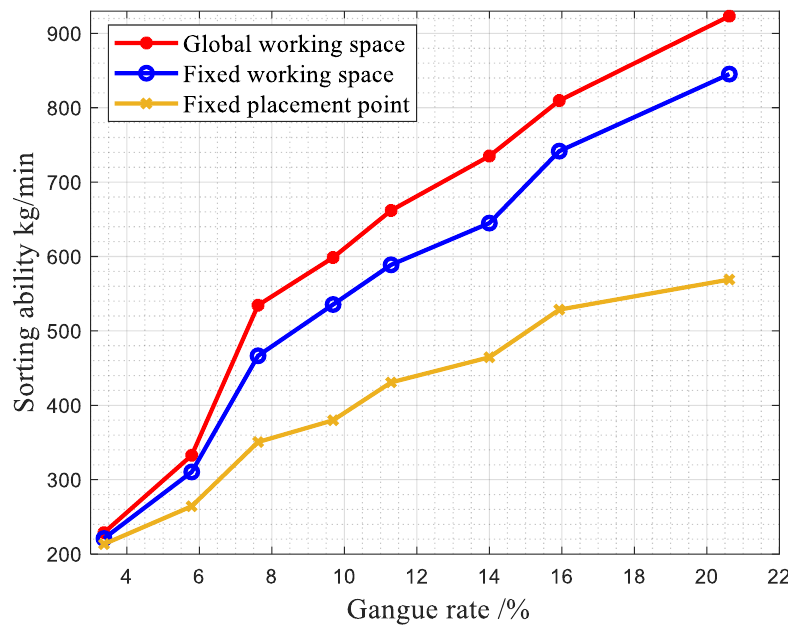
Figure 21. Comparison of sorting capacity at the same belt speed with different gangue contents.